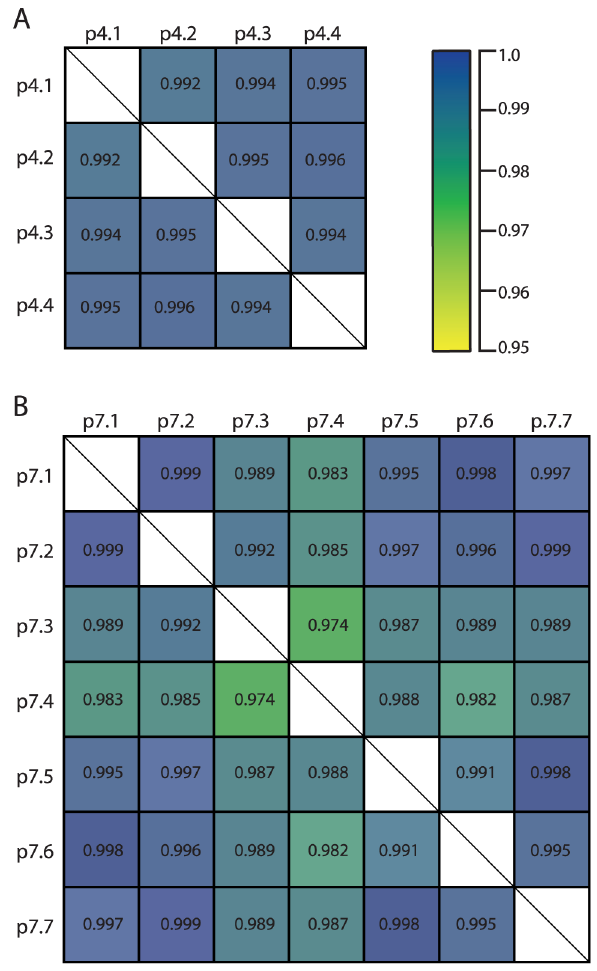
Figure 3. Correlation matrices displaying Pearson’s correlation values for scaled coverage plots quantitatively demonstrate high correlations between invitrosome experiments. 3A Pear- son’s correlation matrix for coverage plots from plasmids p4.1-p4.4. 3B Pearson’s correlation matrix for coverage plots from plasmids p7.1-p7.7. In both matrices, high to lower correlation values range in color from blue to yellow as show.